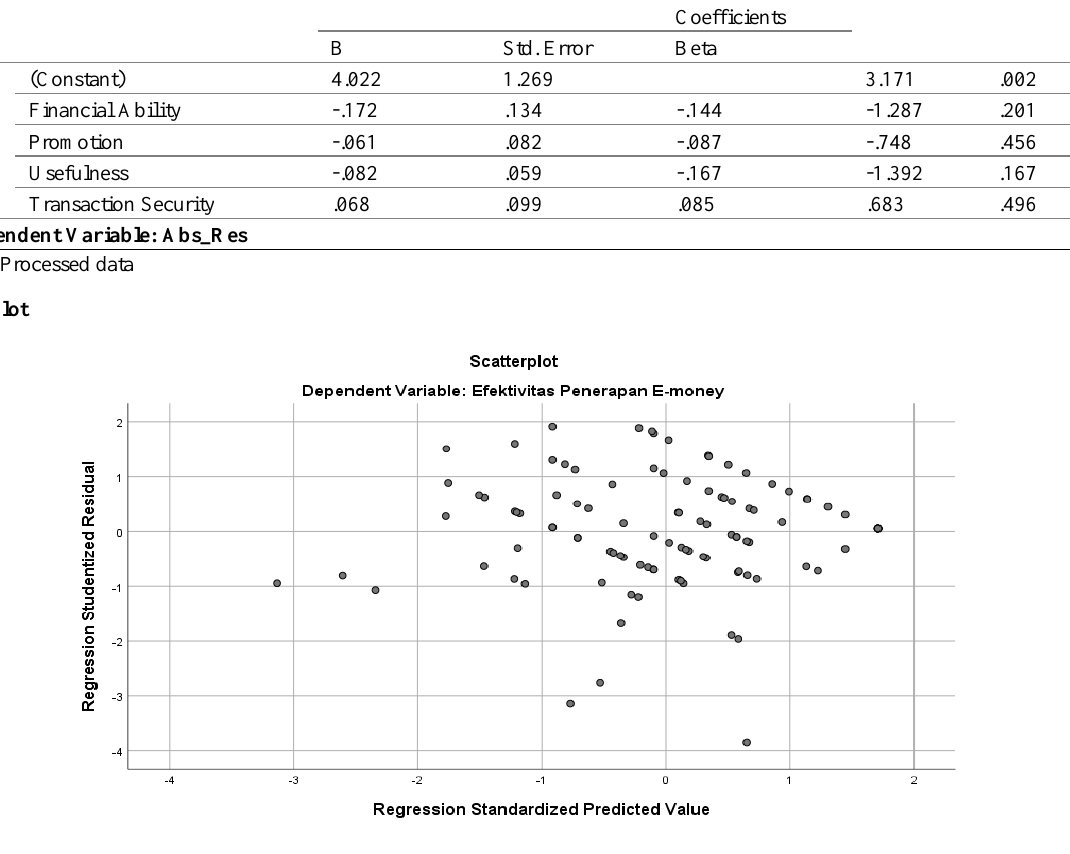
Figure 2: Scatter plot; Source: Processed